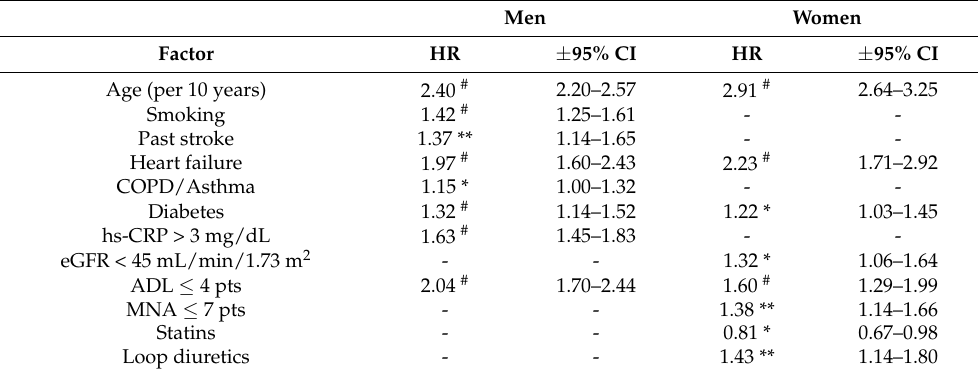
Table 3. Factors associated with overall mortality in non-parametric estimation of hazard ratio curves.